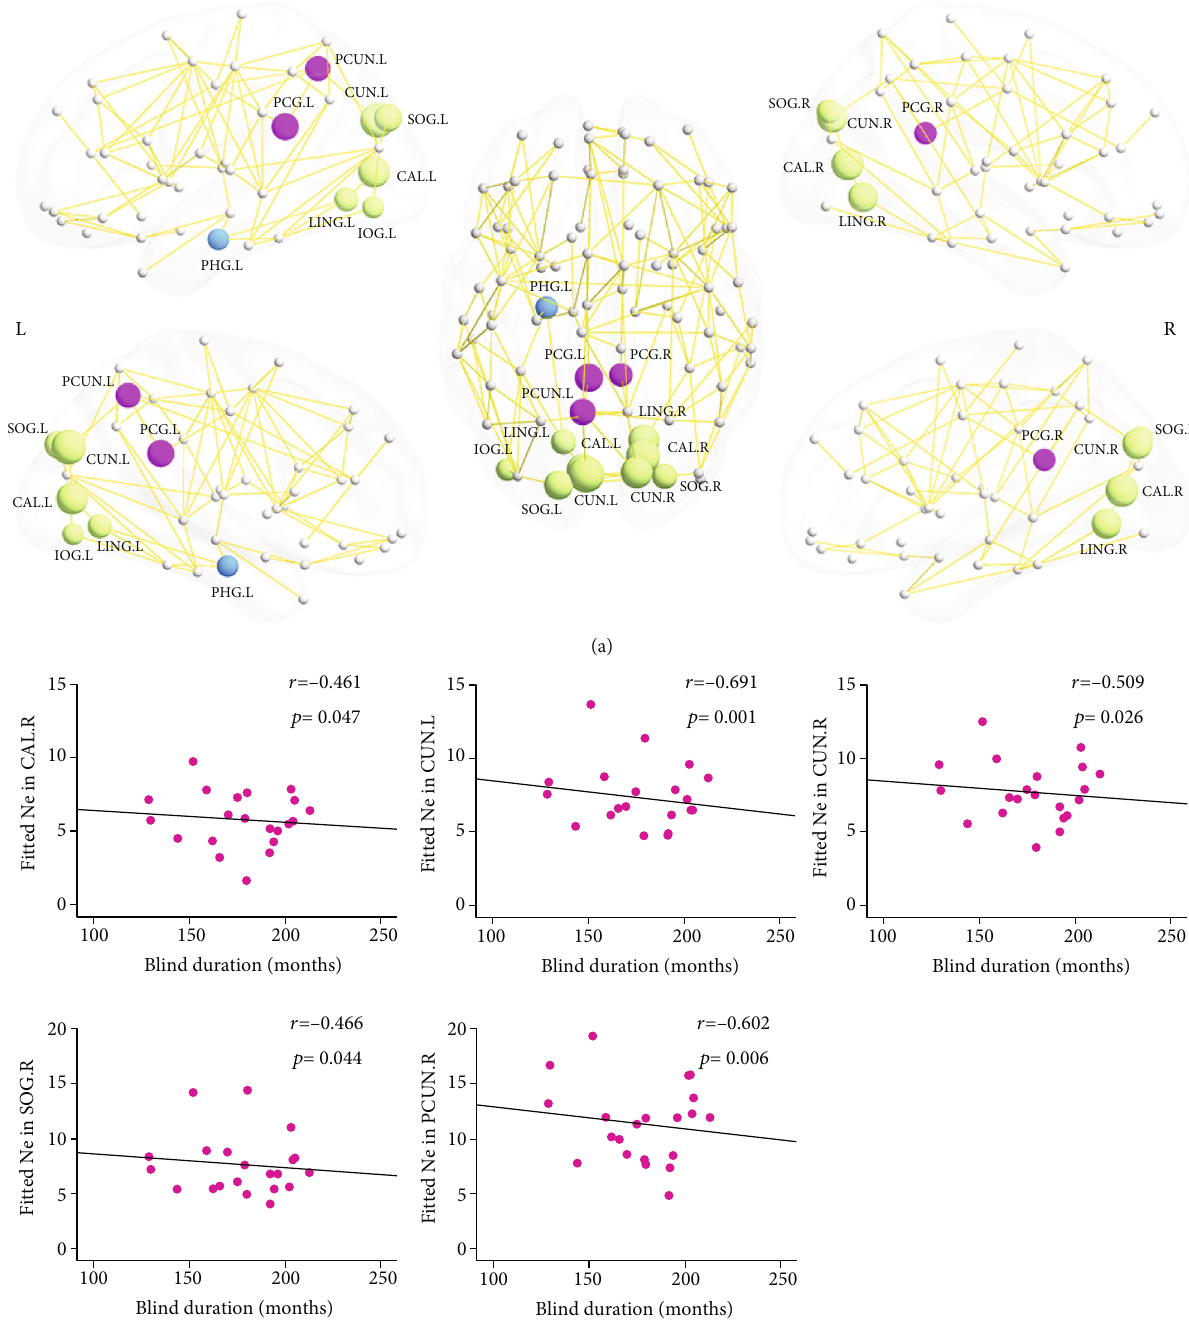
Figure 2: Distribution of brain regions with signi fi cant intercohort di ff erences in nodal e ffi ciency (Ne) (a) and the correlation with blind duration in the EBA cohort (b). (a) Regions with decreased Ne are represented in di ff erent colors: purple for the default-mode system, green for the visual system, and blue for the limbic system. The node sizes indicate the signi fi cance of intercohort di ff erences in Ne. (b) Scatterplots show the signi fi cantly negative correlation between Ne and blind duration in EBA cohort ( n =21). The fi tted values indicate the residuals of original values of Ne adjusted age and sex and corrected with mean value. The abbreviations of nodes can be referred in Table